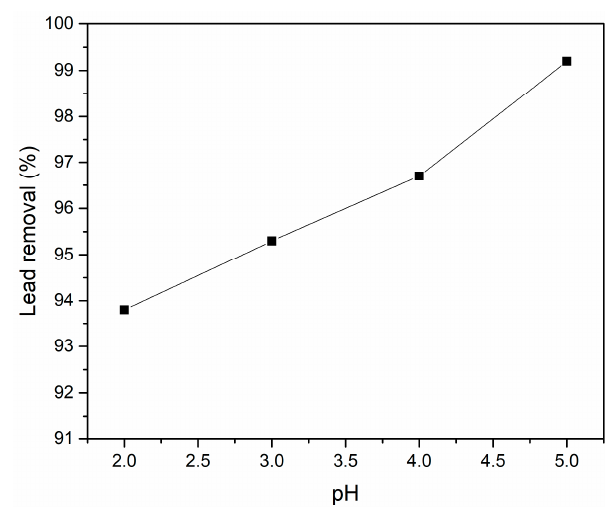
Figure 4. Effect of the solution pH on the removal of Pb 2+ ions by N-HAp powders.